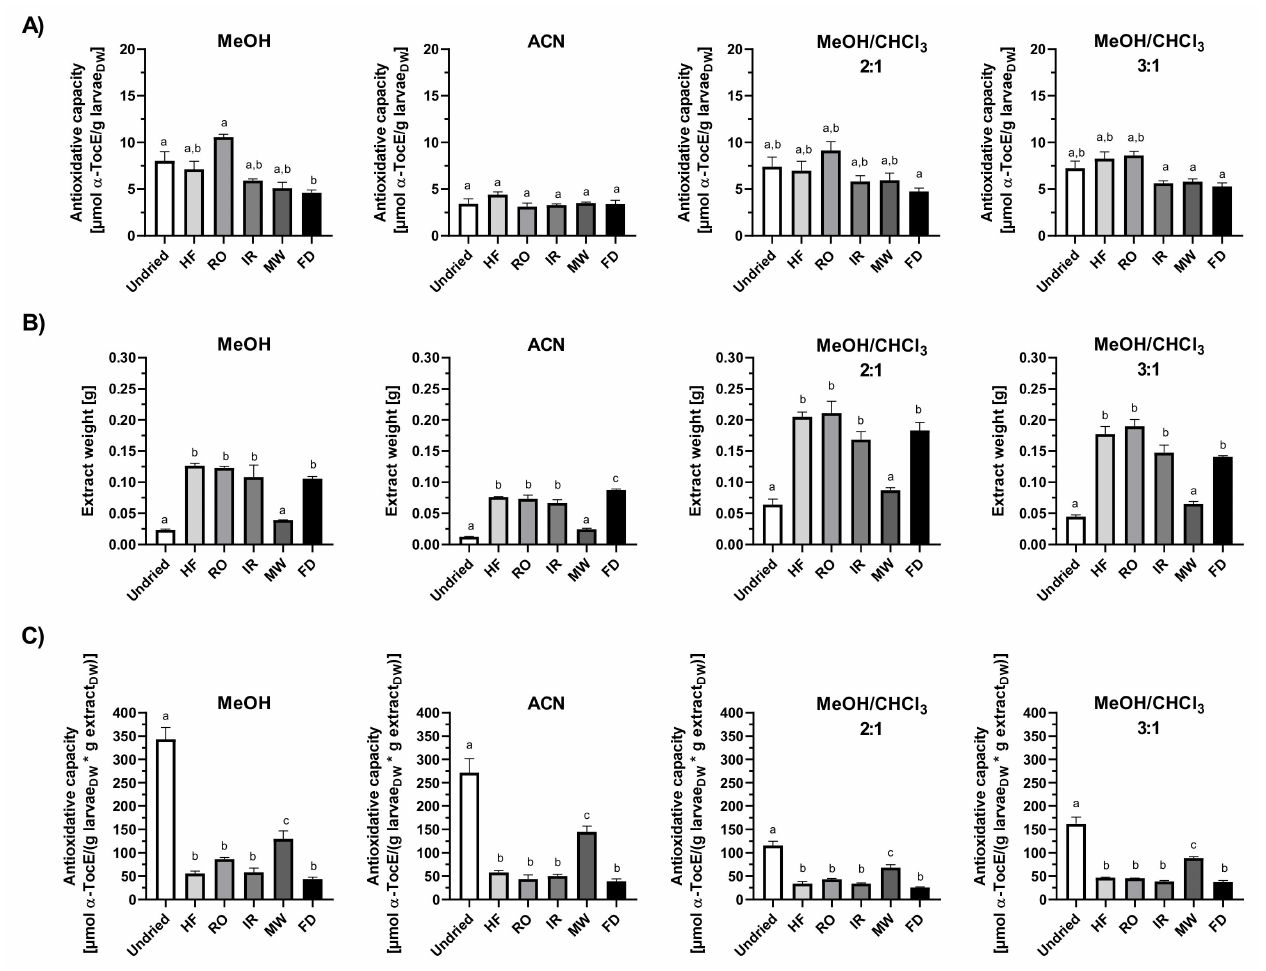
Figure 4. DPPH radical scavenging capacity of T. molitor larvae extracts. Antioxidant capacity of methanol, acetonitrile and methanol/chloroform mealworm extracts measured by DPPH • scavenging assay and normalized to ( A ) the larval dry weight or ( C ) the larval dry weight per extract dry weight. ( B ) Dry weight of extracts obtained from 0.5 g larval material each as a measure of extraction efficiency. Data are shown as means ± SEM of three replicates. Significantly different means within one panel do not share the same letters (analysed by one-way ANOVA with Tukey’s multiple comparison test, p < 0.05). DW = dry weight, α -TocE= α -tocopherol equivalent. DW = dry weight, GAE = Gallic acid equivalent. DW = dry weight, TE = Trolox equivalents. HF = high-frequency dried, RO = rack oven-dried, IR = infrared dried, MW = microwave dried, FD =